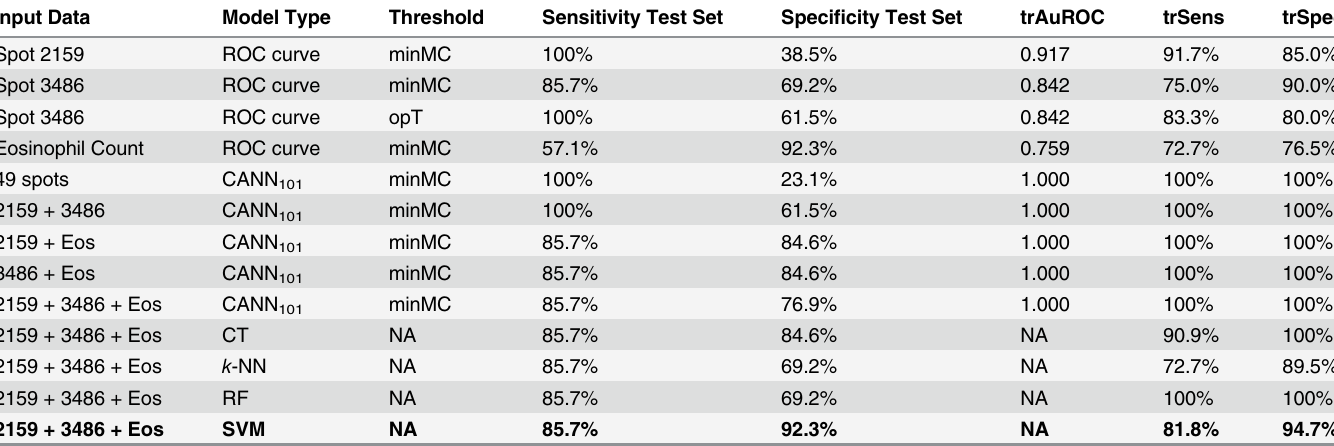
Table 4. Statistical performance of models to discriminate DAT cases in an independent test set.